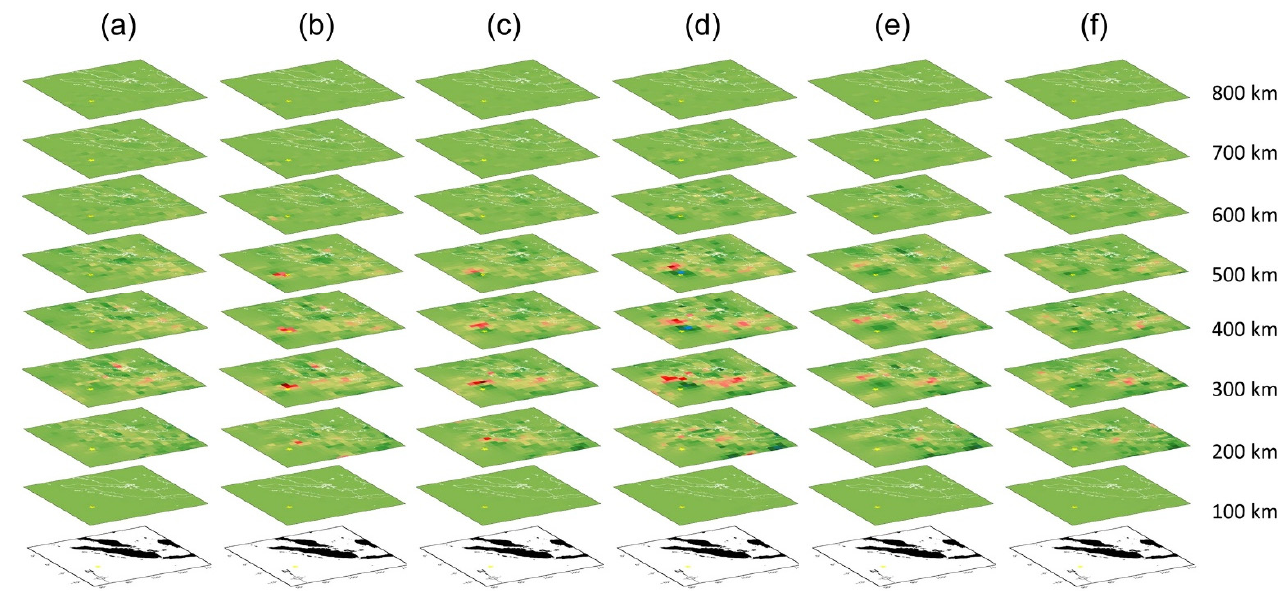
Figure 6. Electron density anomalies at heights from 100 km to 600 km before the 2016 West Sumatra earthquake were derived by the 3-D tomography at six epochs, that is, ( a – f ) 10–20 min after the earthquake. The white curves show coastlines and national boundaries, and the yellow star indicates the epicenter.